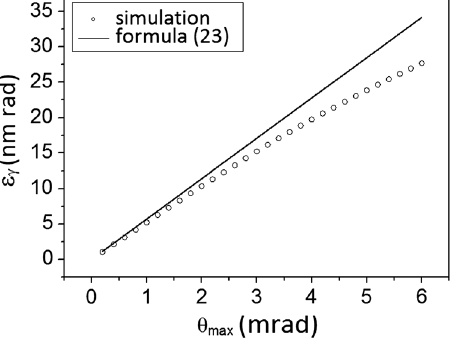
FIG. 2. Case A: ϵ γ (nm rad) value from CAIN simulation vs formula (23) as a function of θ